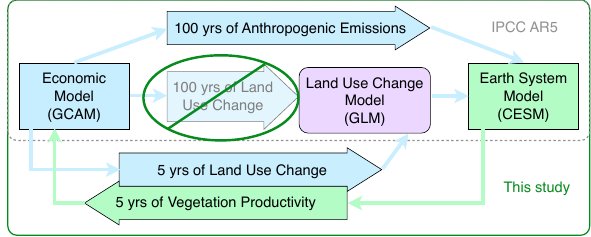
Figure 1. Implementation of iESM terrestrial feedbacks. The light blue arrows show information flow from GCAM to CESM. The light green arrows show information flow from CESM to GCAM. The dashed gray outline, including the arrow crossed out by green, represents the CMIP5 land coupling. The solid green outline, minus the arrow crossed out by green, depicts the iESM implementation used in this